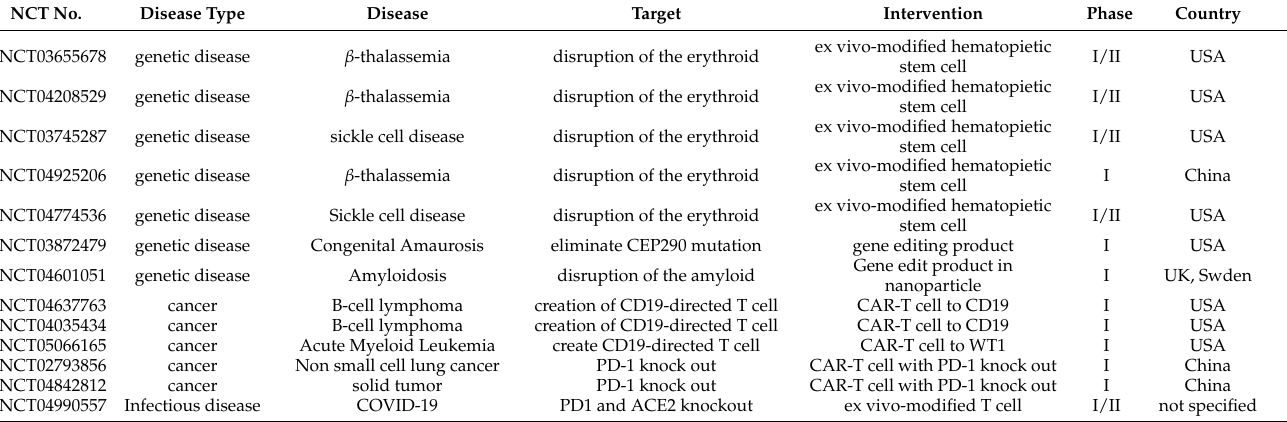
Table 1. Currently registered interventional clinical trials with CRISPR-Cas9-based gene editing. NCT